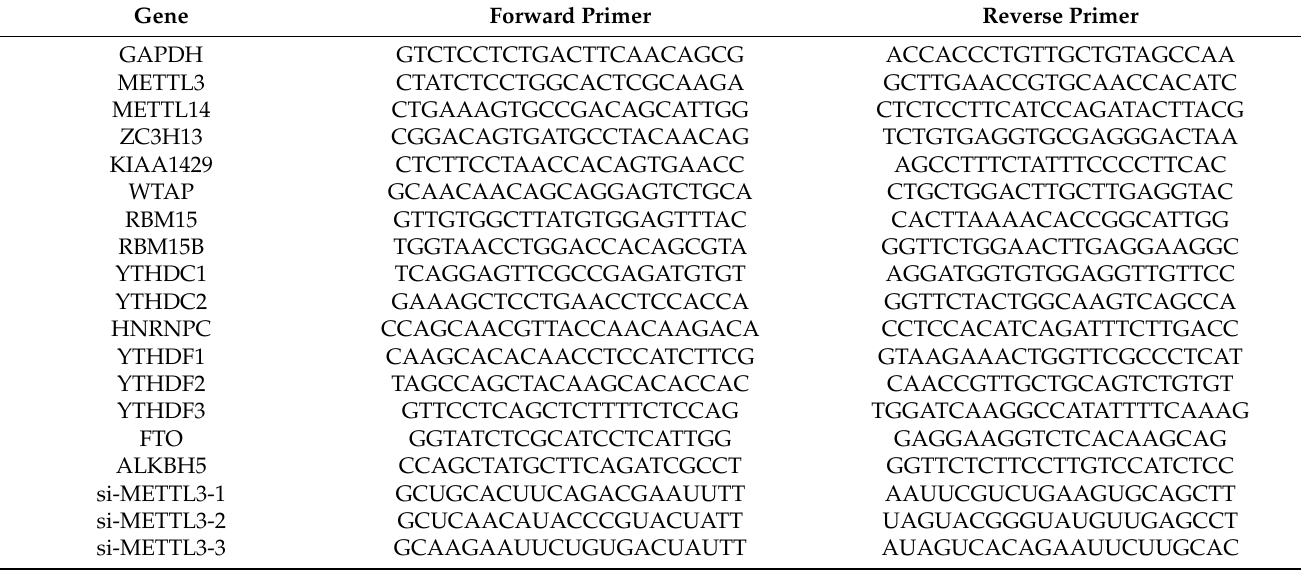
Table 1. Summary of the oligonucleotide primer and siRNA